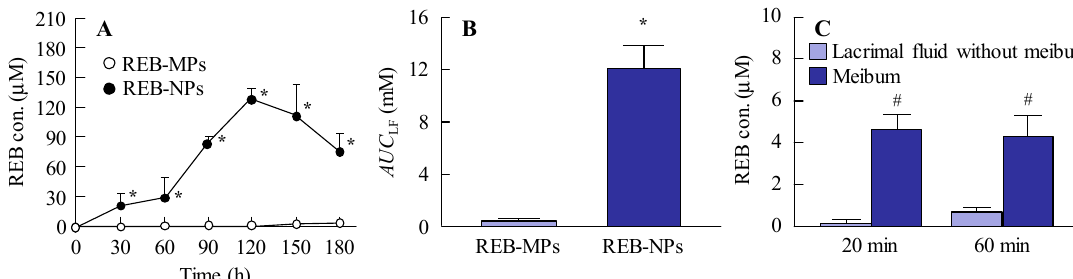
Figure 4. Changes in rebamipide levels in the lacrimal fluid and meibum of rabbits receiving a single treatment of REB-NPs or REB-MPs. ( A ) Rebamipide profile and ( B ) AUC LF in the lacrimal fluid after the application of REB-MPs or REB-NPs. ( C ) Rebamipide levels in the meibum and lacrimal fluid without meibum after the application of REB-MPs or REB-NPs. Here, 20 min and 60 min after the application of REB-NPs, the lacrimal fluid without meibum was collected from the eyelid side using Schirmer tear test strips. n = 5–7. * P < 0.05, vs. REB-MPs for each group. # P < 0.05, vs. lacrimal fluid without meibum for each group. The rebamipide in the REB-NPs penetrated the eyelid, and was delivered to the lacrimal fluid through the meibomian glands.